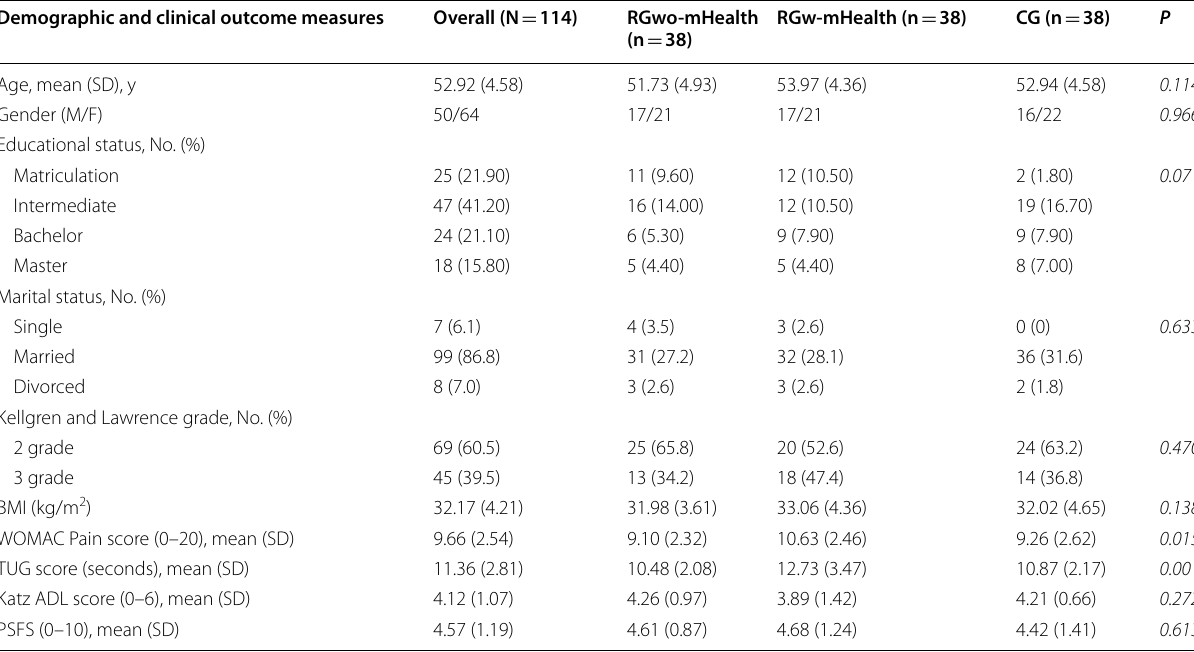
RGw-mHealth, rehabilitation group with mobile health; RGwo-mHealth, rehabilitation group without mobile health; CG, control group; WOMAC, Western Ontario and McMaster Universities Osteoarthritis Index; BMI, body mass index; SD, standard deviation; TUG, timed up and go; ADL, activities of daily living; PSFS, patient specific functional scale; n, number